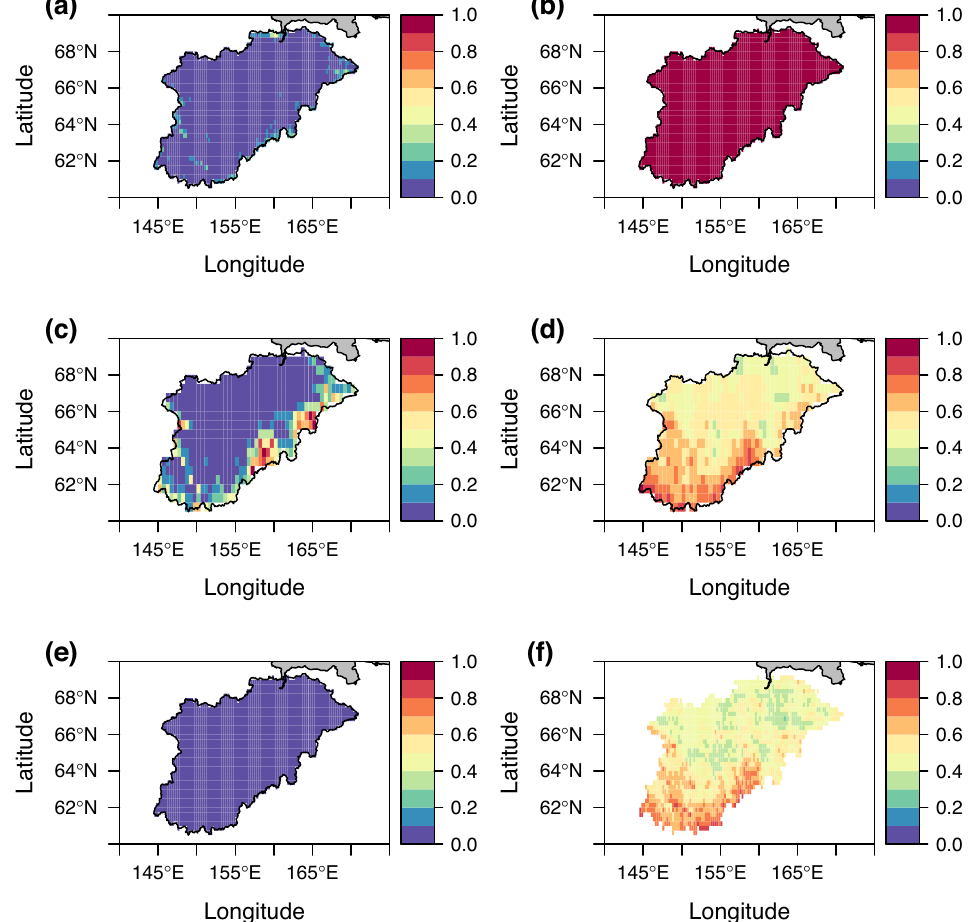
Figure 7. Climatological spatial distribution of snow cover fraction by satellite-based observation and two different model simulations: ( a , b ) Denote satellite-based SCF in June and October, respectively; ( c , d ) Denote CHANGE-based snow cover fraction in June and October, respectively; ( e , f ) Denote NOAH-based snow cover fraction in June and October,